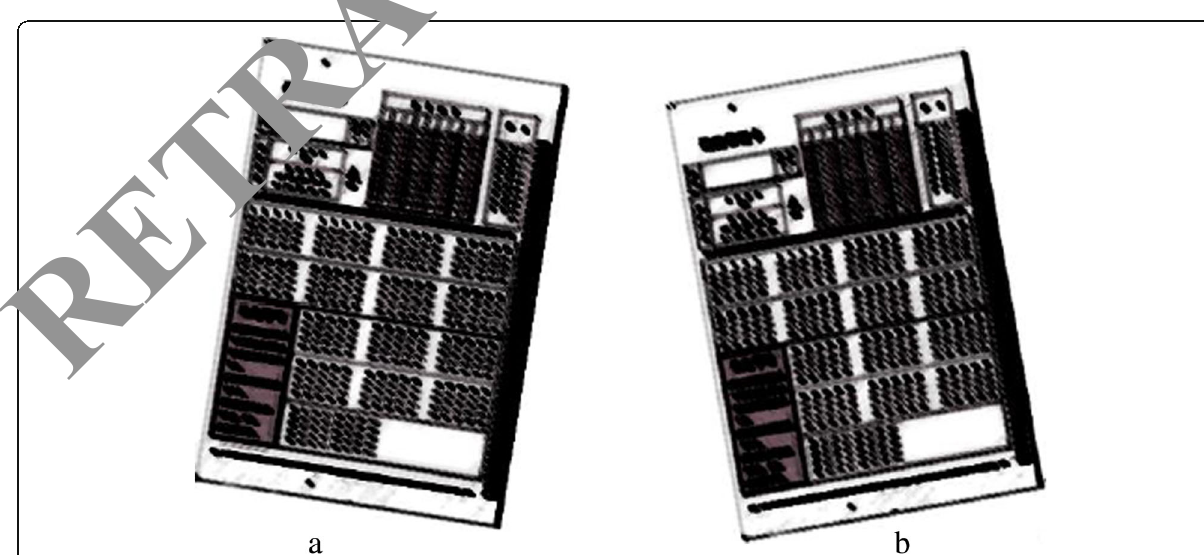
Fig. 3 Detection effect of image edges based on wavelet transform ( a , b